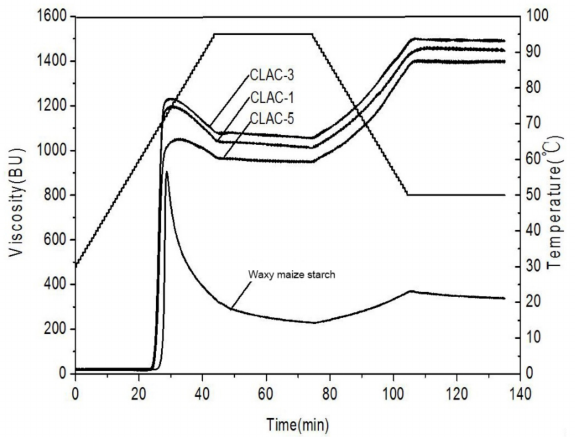
Figure 3. Brabender viscosity curve of CES.